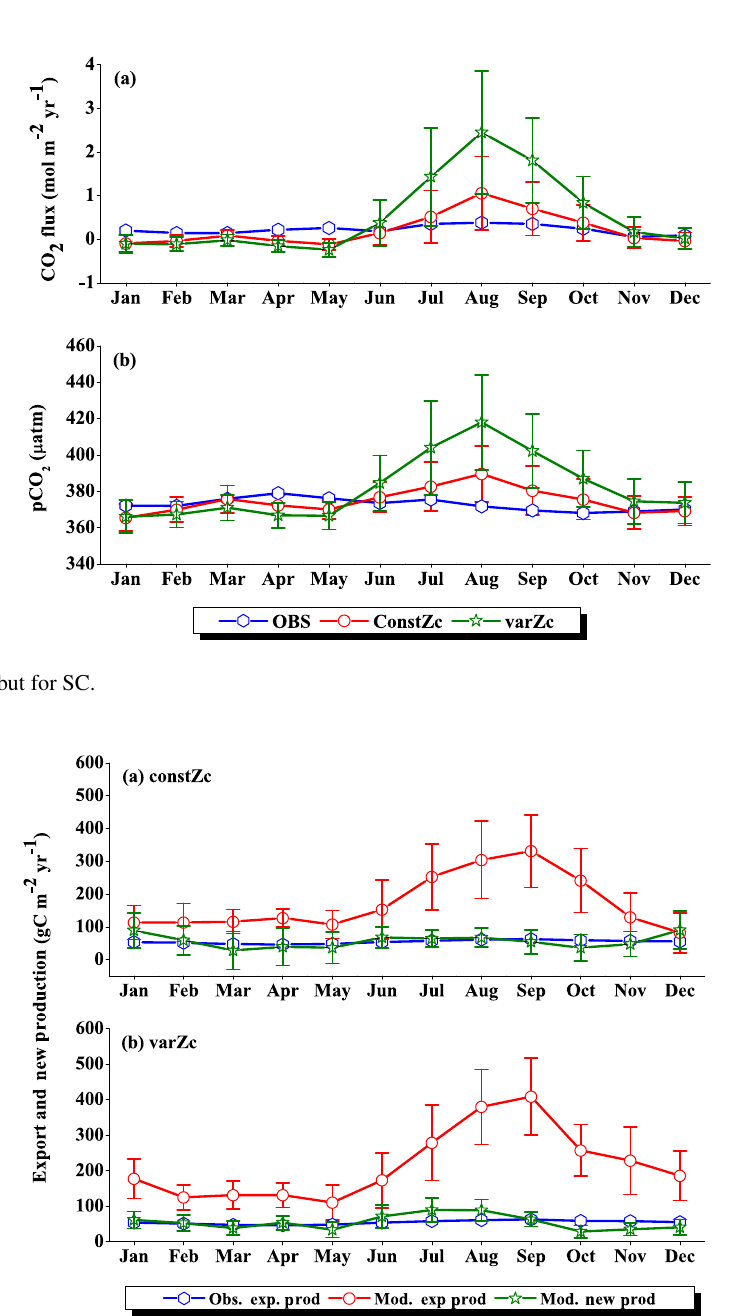
Figure 13. Same as Fig. (7), but for